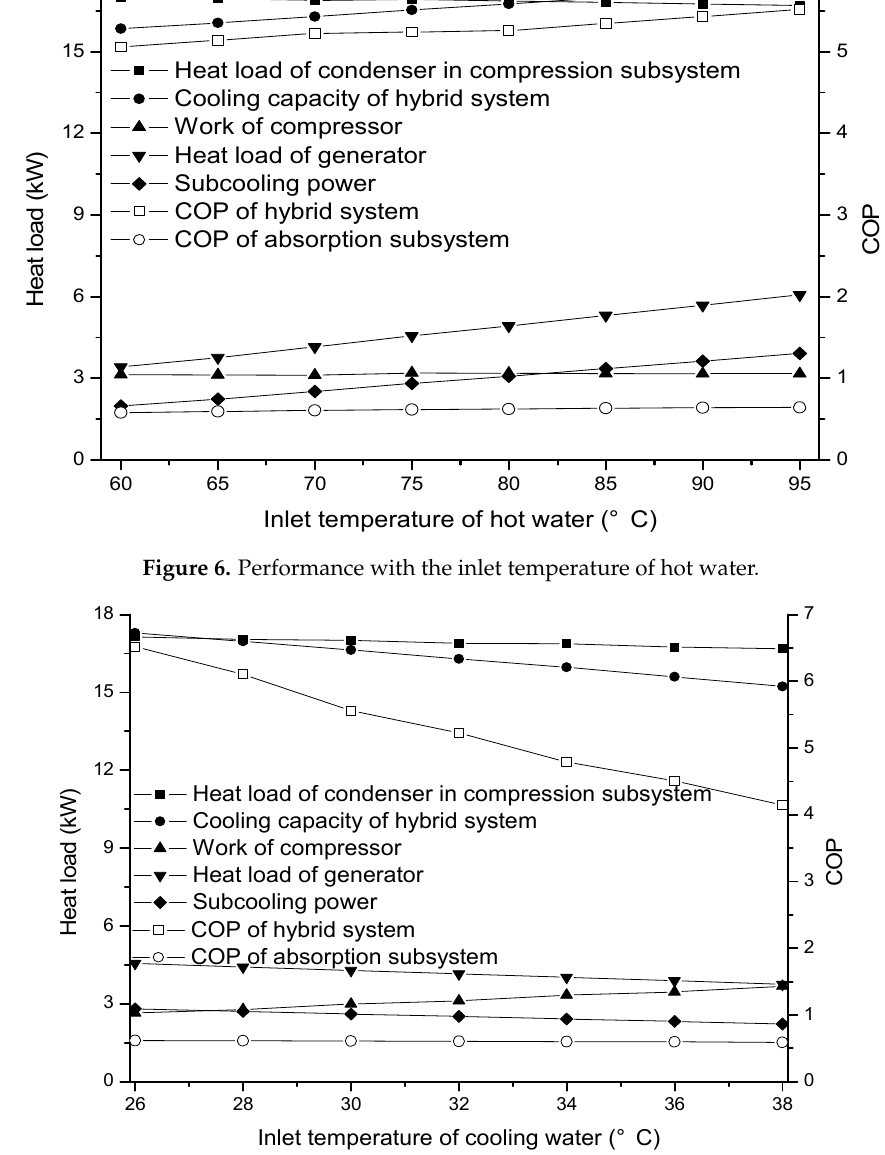
Figure 7. Performance with the inlet temperature of cooling water.